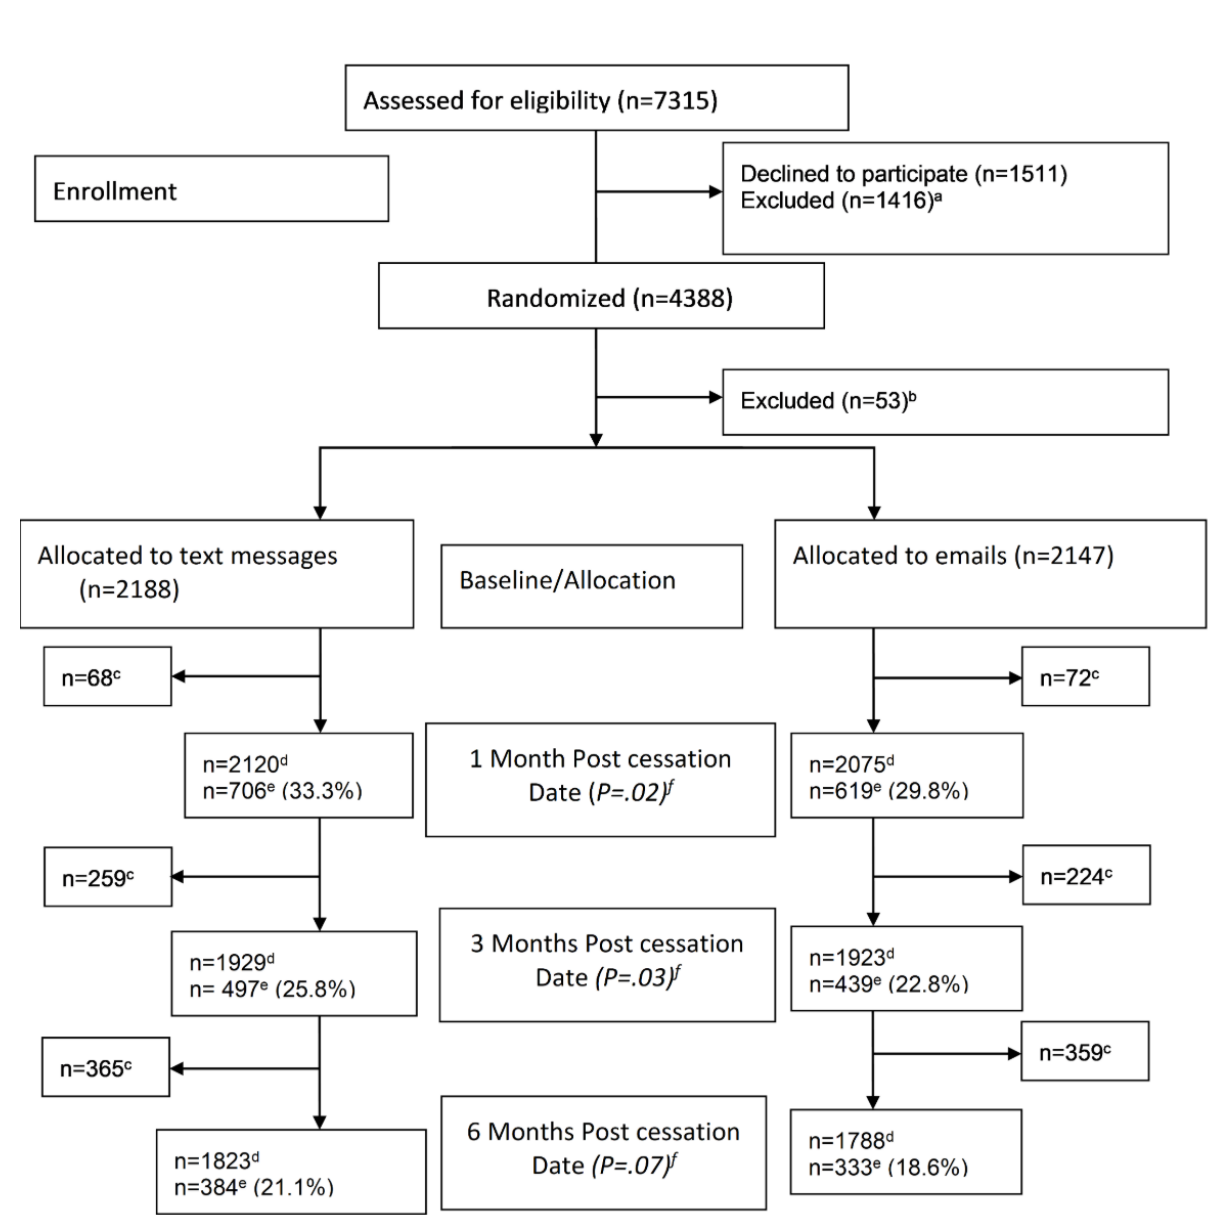
Figure 1. Consolidated Standards of Reporting Trials’ diagram. Randomized controlled trial, Norway 2010-2012 (N= 4335). a – already stopped smoking (n=631); did not complete baseline registration (n=517); not smoking cigarettes (n=20); referred to substudy (n=248). b – text message/email arm; consent withdrawn n=29 (17/12); missing/double allocation n=24 (12/12). c – participants that had not completed the next follow-up time point. d – Participants included in the analysis. e – responders to follow-up email questionnaire. f – Chi-square statistics; P value for difference between